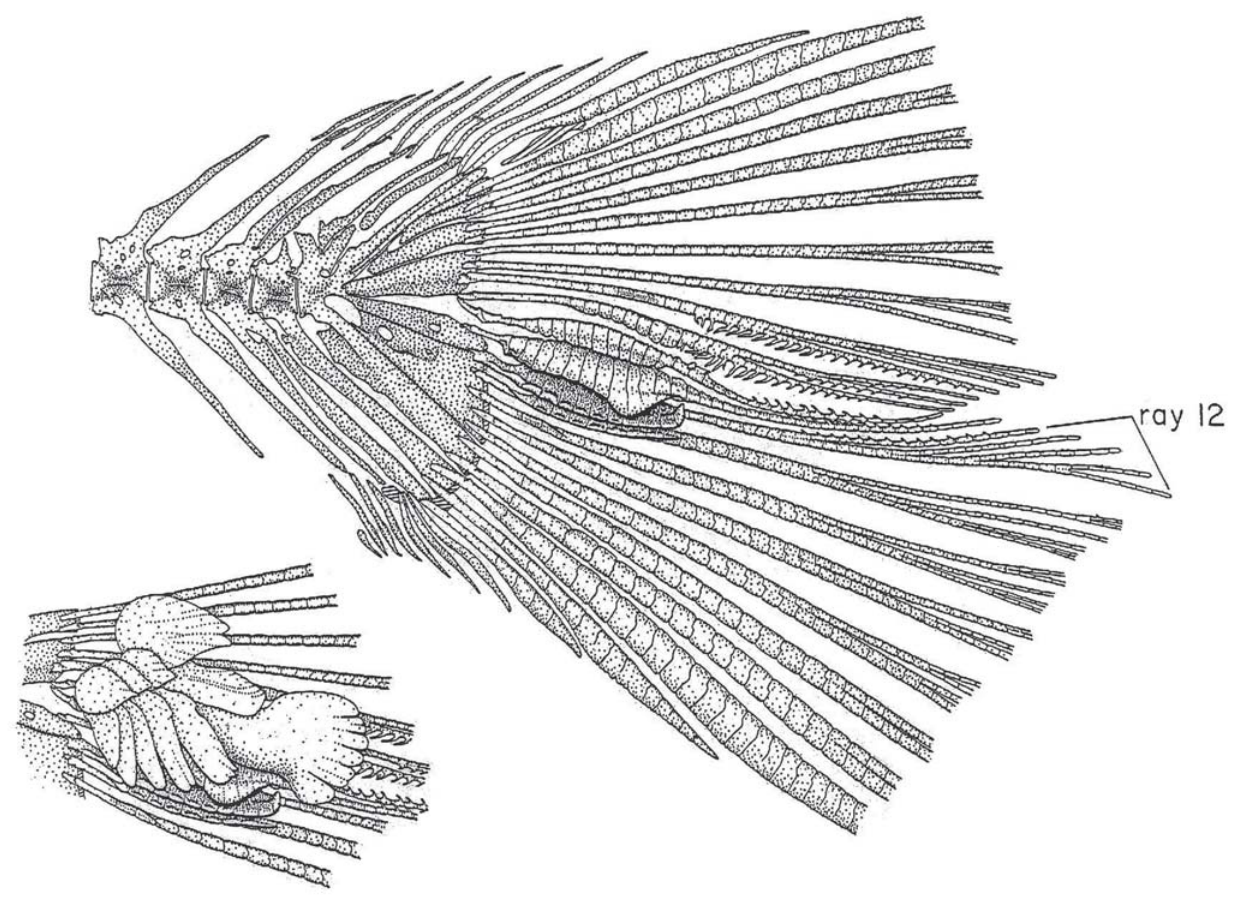
Fig. 85. Mimagoniates microlepis , adult male, USNM 236089, 45.3 mm SL; osteology of caudal skeleton and caudal-fin squamation (lower left), lateral view, left side. Principal caudal ray 12 indicated. Relationship of modified dorsal lobe caudal-fin squamation to caudal gland shown in inset at lower left. Distal regions of ventral and posterior scales and their epidermis form flap partly covering intake openings of pump chamber. Modified from Menezes et al .